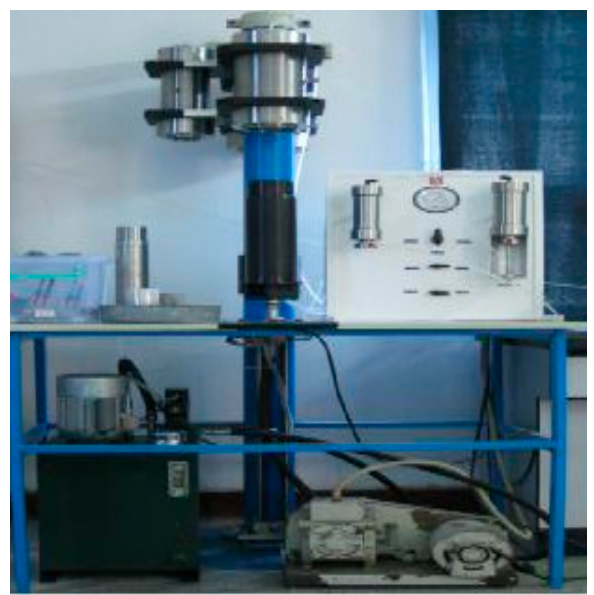
Figure 9. Low permeability measurement instrument.